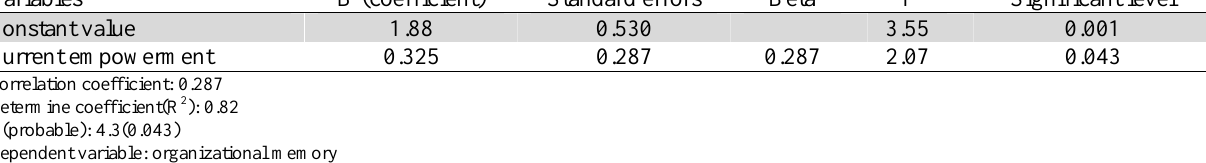
Regression model of effect of employee’s psychological empowerment on organizational memory Variables